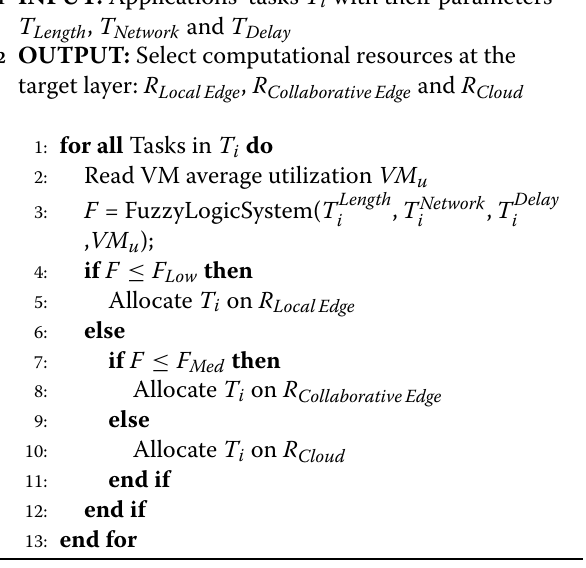
sensitivity. Second, Flroes [63] proposed a task offload- ing approach based on fuzzy logic for IoT applications. This approach aims to decide whether to offload to the